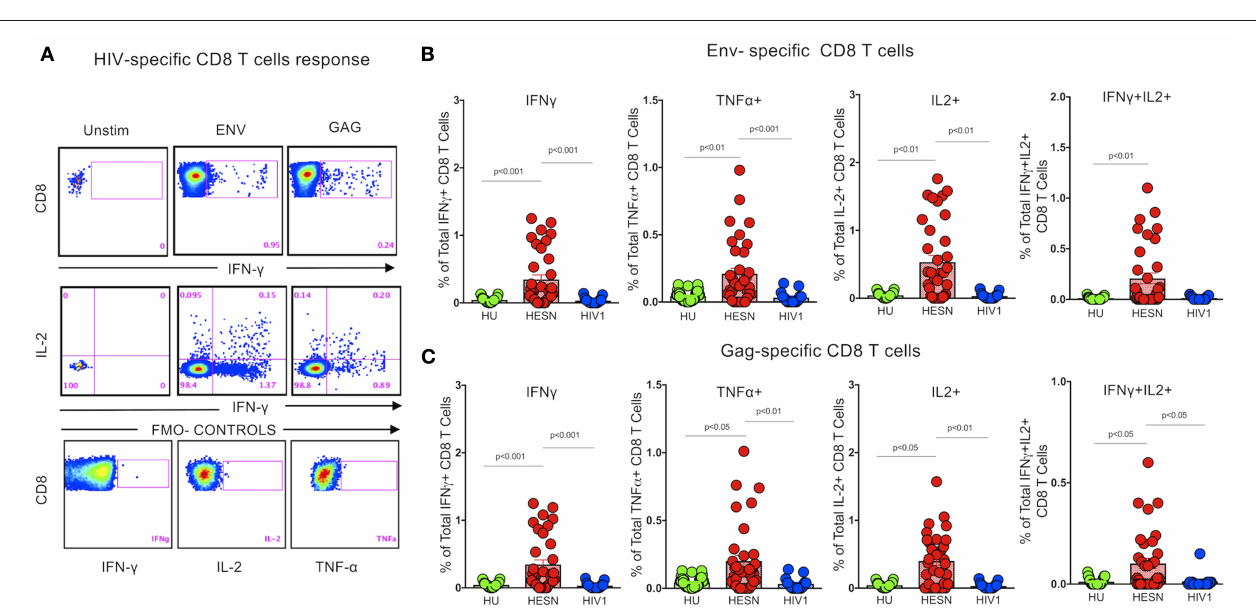
FIGURE 3 | Enrichment of HIV peptide-specific CD8 + T cells. Detection of HIV-specific CD8 + T cell responses using the ICS assay. Cryopreserved PBMCs from HESN and HU subjects were stimulated with HIV-Pol, -Env, and -Gag peptides or DMSO (negative control) or with SEB (positive control), then stained with surface antibody cocktails, in conjunction with intracellular anti-IFN- γ , TNF- α , and IL-2 antibody, and subjected to analysis by flow cytometry. (A) The numbers in each plot denote the percentage of IFN- γ producing CD8 + T cells after stimulation, and the percentage of multi-functional IFN- γ + IL-2 producing CD8 + T cells after stimulation. (B) Percentage of IFN- γ , TNF- α , IL-2, and multi-functional IFN- γ + IL-2 + Env-specific CD8 + T cells in the study groups. (C) Percentage of IFN- γ , TNF- α , IL-2, and multi-functional IFN- γ + IL-2 + Gag-specific CD8 + T cells in the study groups. The dot plots represent the median, 25th and 75th percentile and range (IQR). P- values were determined using Mann-Whitney’s T- test. (HESN, HIV exposed seronegative; HIV-1, Progressors; HU, HIV unexposed seronegative